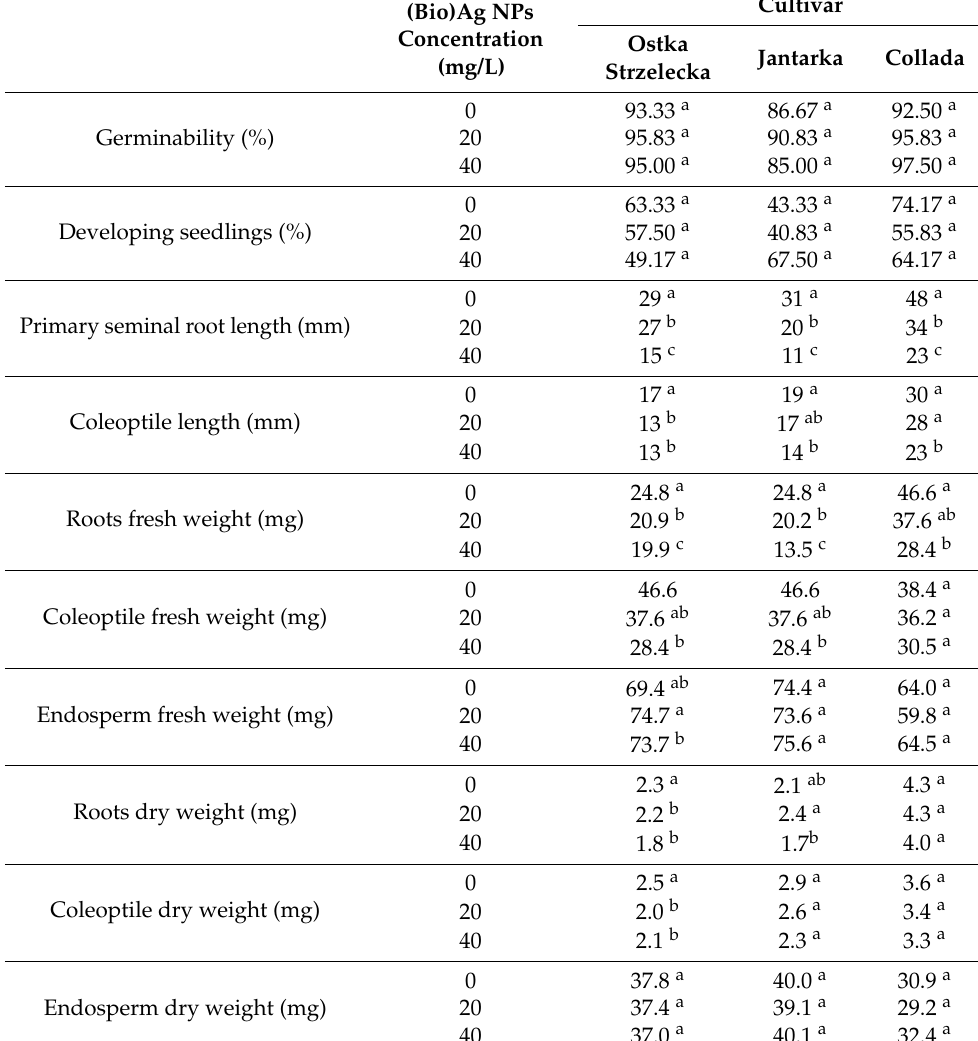
Table 1. The effect of (Bio)Ag NPs on germinability, percentage of developing seedlings, length of primary seminal root and coleoptile, and the fresh and dry weights of roots, coleoptile (including covered shoot), and endosperm (including pericarp) in 3-day-old seedlings of wheat cultivars. Values are means ( n = 4). The same superscript letters by the values indicate no significant ( p < 0.05) differences according to the ANOVA test and post hoc Tukey’s corrections (calculated for each column and cultivar separately). Developing seedlings means seedlings with normal coleoptile and one-two pair of seminal roots each at least 3–4 mm